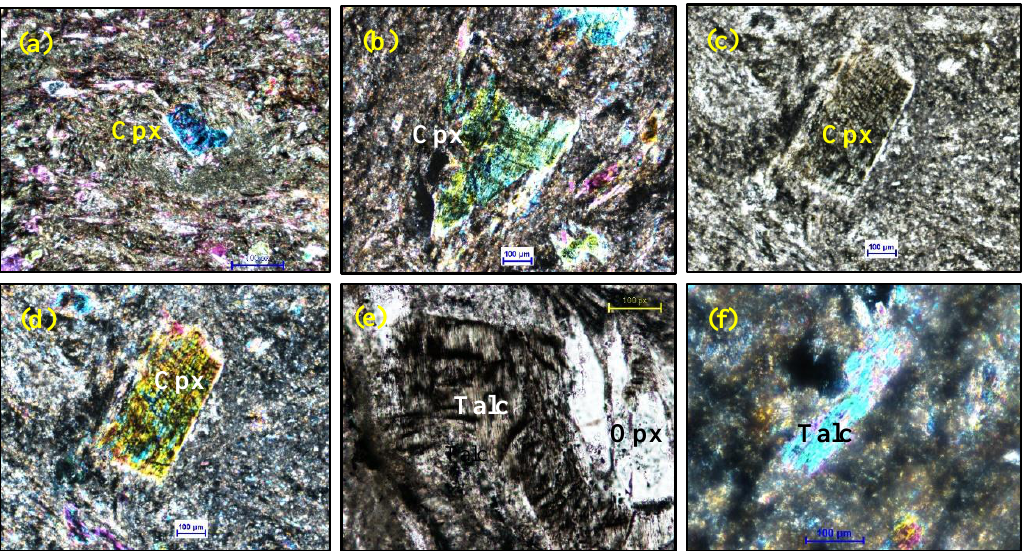
Figure 3. Photomicrographs of Holenarsipur high-Si high-Mg volcanic rocks. The rocks are exhibit porphyritic texture with clinopyroxene ( a – d ), and orthopyroxene ( e ) in the phenocryst phase, and talc ( f ) in the groundmass. Note that all the photographs have been taken under uniform magnification of 100 μm. See text for details.